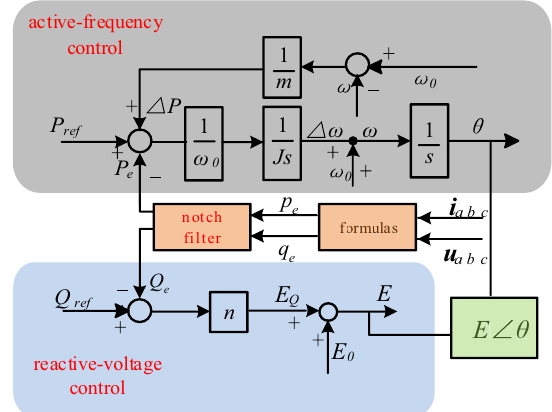
Fig. 2 Control system block diagram of the